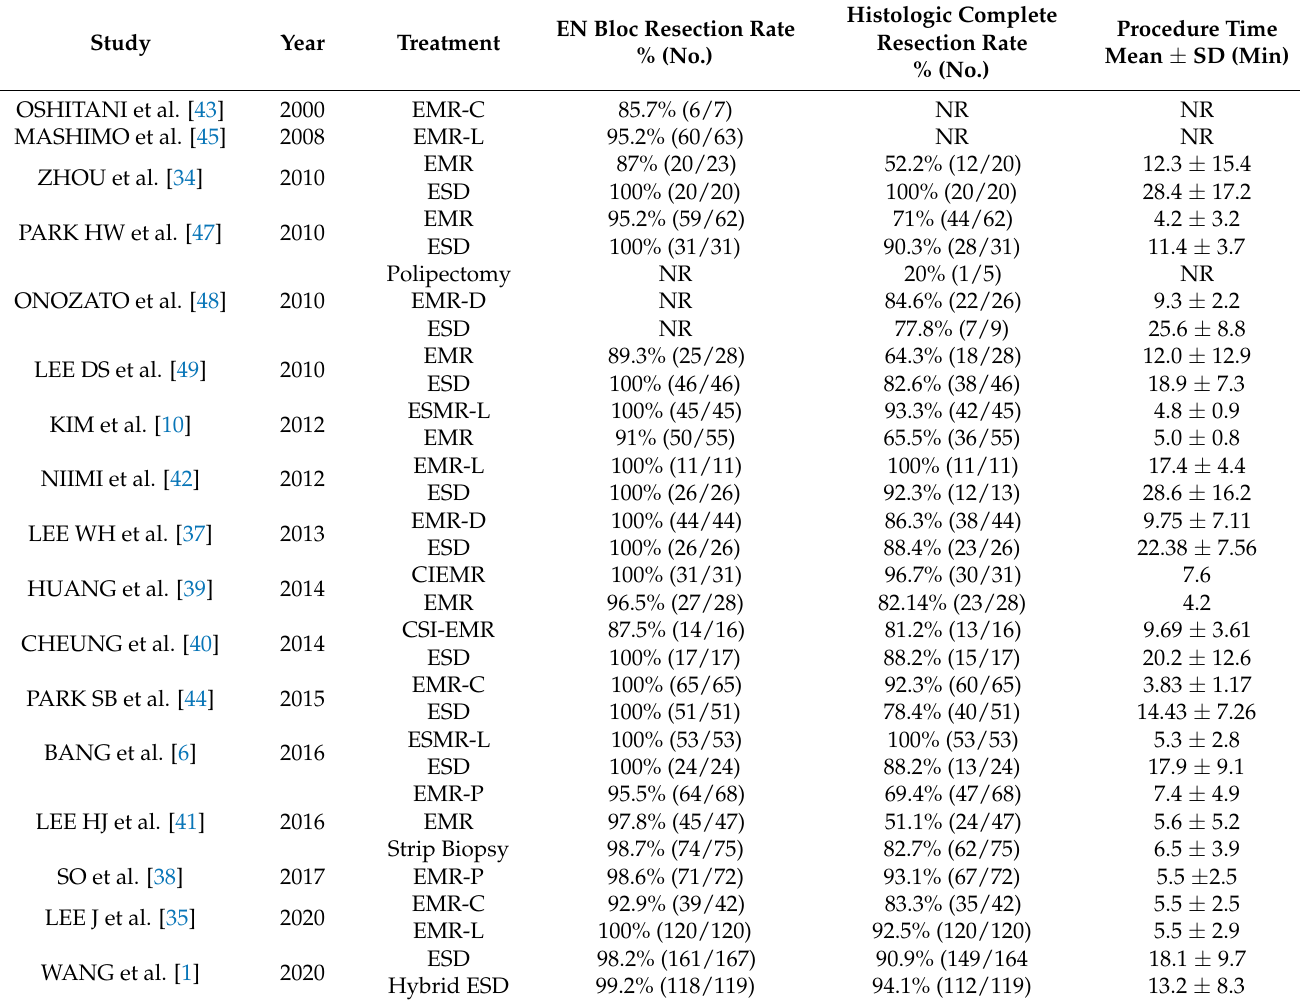
Table 3. Characteristics of studies comparing the different techniques of endoscopic